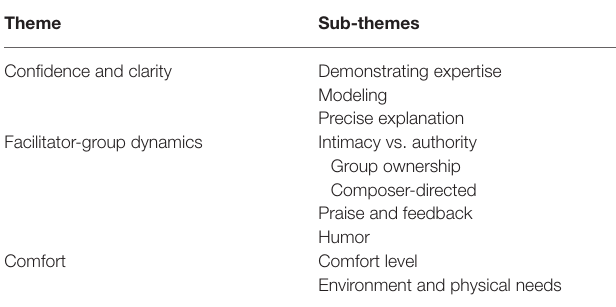
TABLE 2 | Coding framework for facilitator